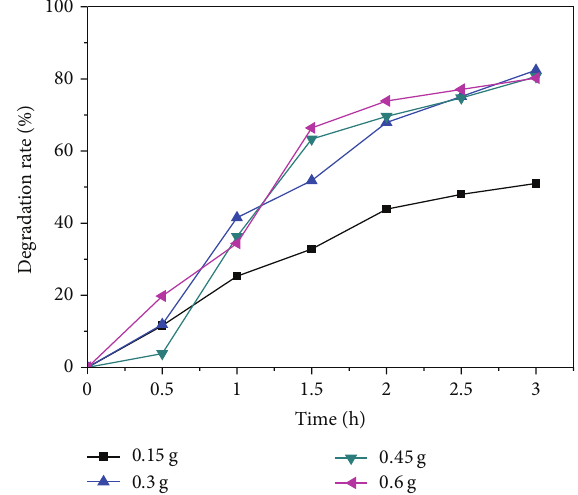
Figure 6: Effect ofcatalyst dosage on thephotocatalytic degradation rate of methyl violet.